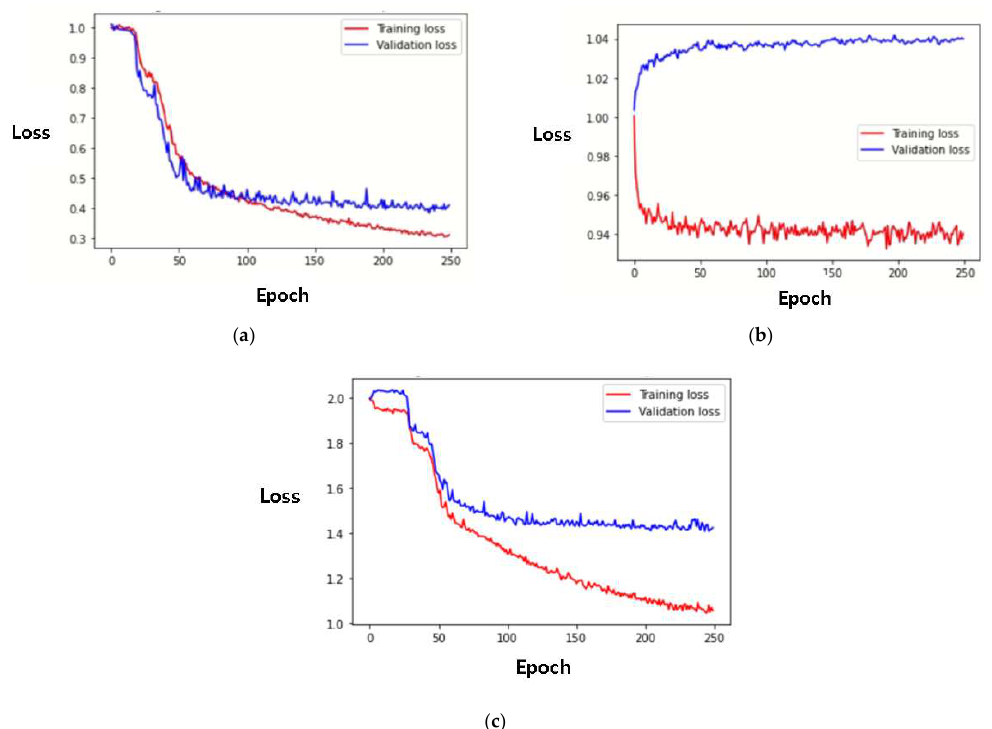
Figure 7. Learning curves of the rPPG-prediction models. ( a ) Learning curves of the Siamese network with convolution block attention module (CBAM) for the prediction of the PPG signal. ( b ) Learning curve of the Siamese network with CBAM for the prediction of the respiratory signal. ( c ) Learning curve of MTS for the predictions of both PPG and respiratory signals. Learning curves (shown as loss) of the Siamese network with CBAM and MTS for the predictions of PPG and respir- atory signals are displayed over a span of 250 epochs.